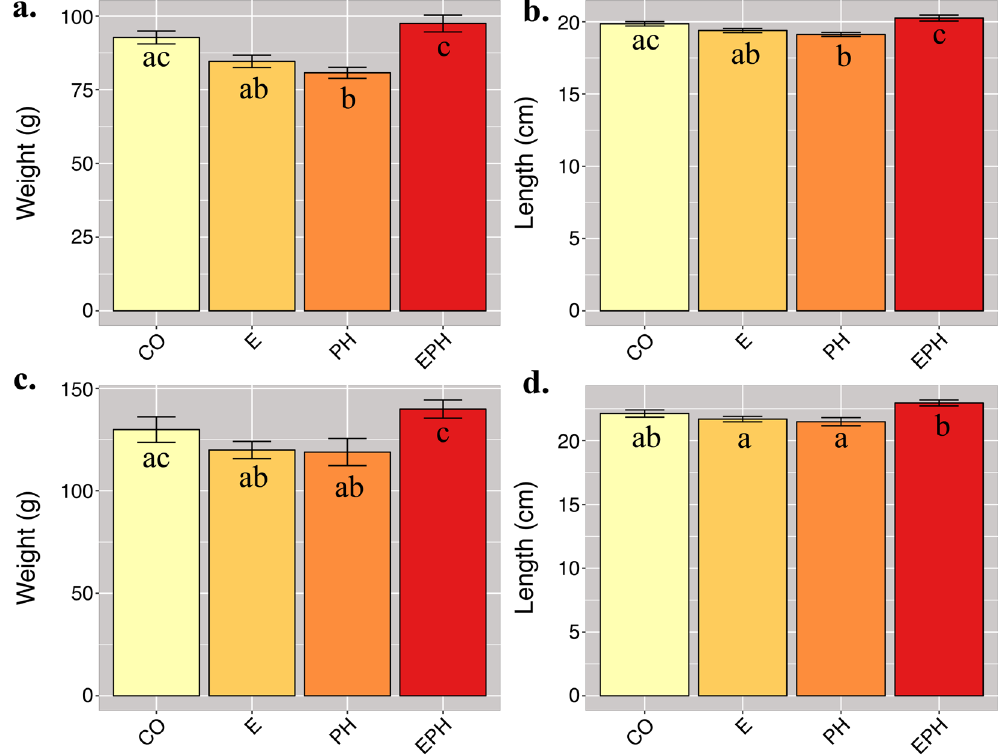
Figure 5. Weight (g) ( a and c ) and length (cm) ( b and d ) of the fish in different treatment groups at the time of transfer to the seawater (day 0) ( a and b ) or 35 days after seawater transfer (35‰ salinity) ( c and d ). Different superscript letters indicate statistical significant differences ( p <